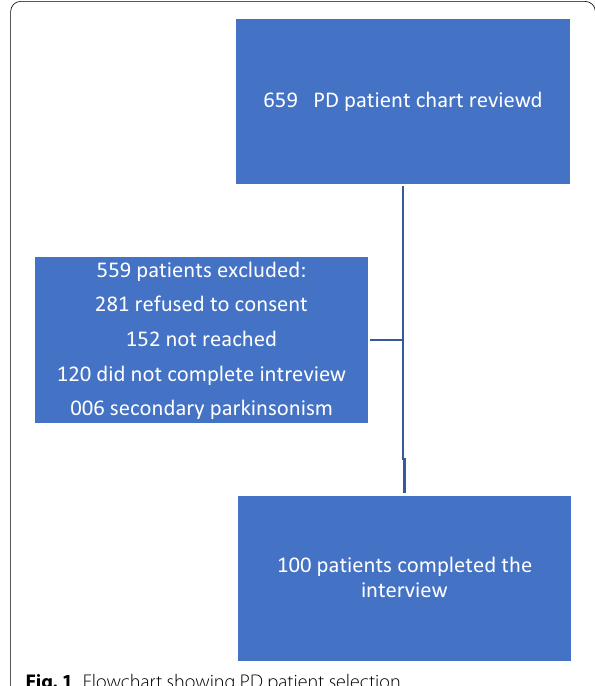
Fig. 1 Flowchart showing PD patient